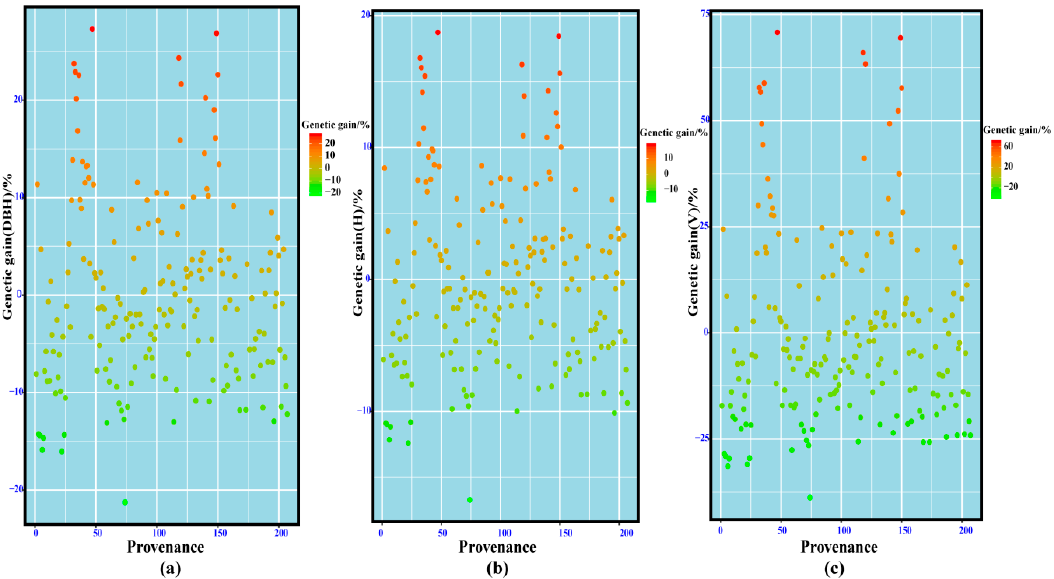
Figure 5. Evaluation of the selection of excellent provenancesfor Chinese fir.The subfigure ( a ), ( b ), ( c ), shows the geneticgain of DBH, tree height and volume, respectively.The horizontal axis represents the provenance number and the vertical axis represents the geneticgain of trait.